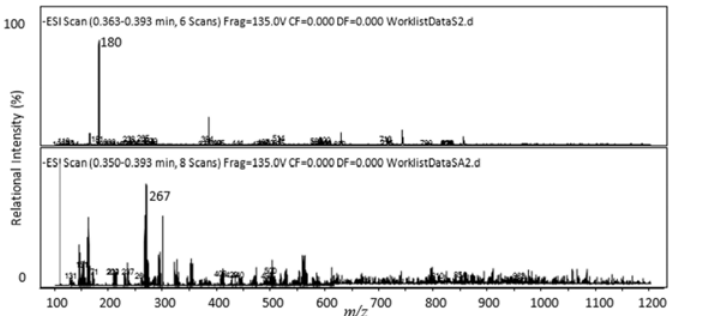
Fig 8. Liquid chromatogram-mass spectrum (LC-MS) profile of product D.